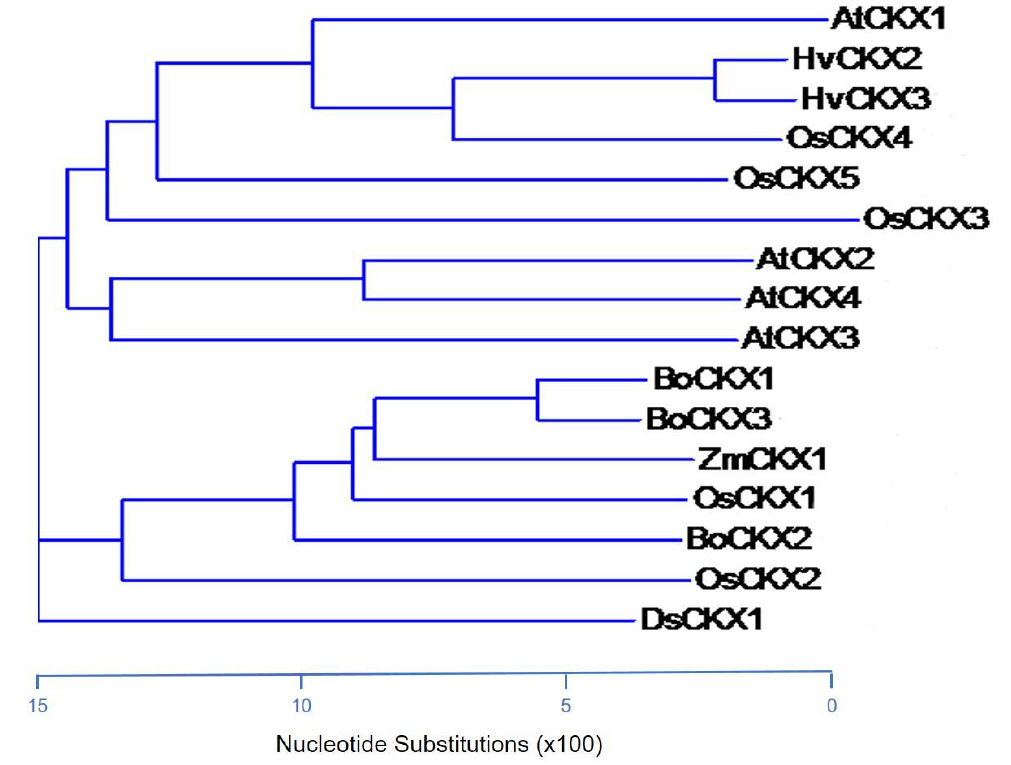
Figure 4. Phylogenetic analysis of CKXs from other plant species by Vector NTI Suite 10 Sequence Software (Invitrogen, Waltham, MA, USA).